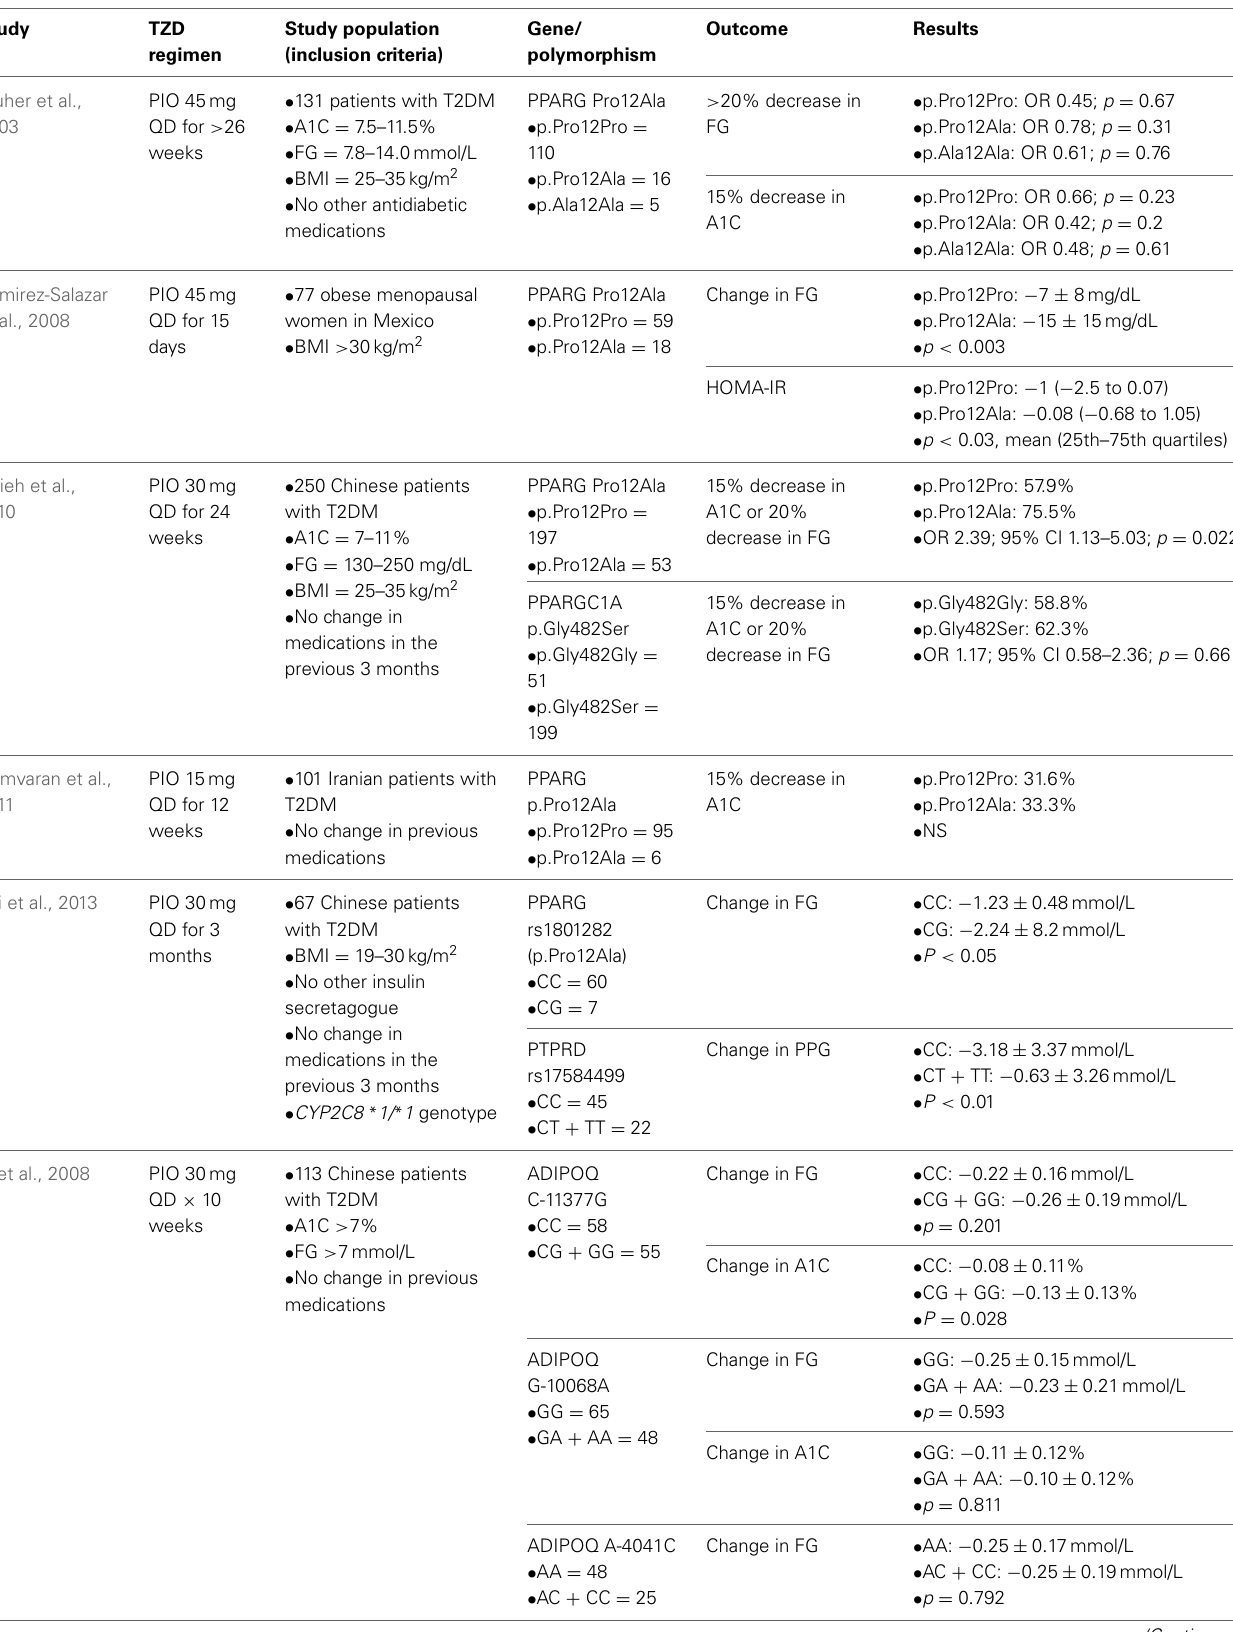
Table 2 | Effect of genetic polymorphisms on pioglitazone pharmacodynamics.